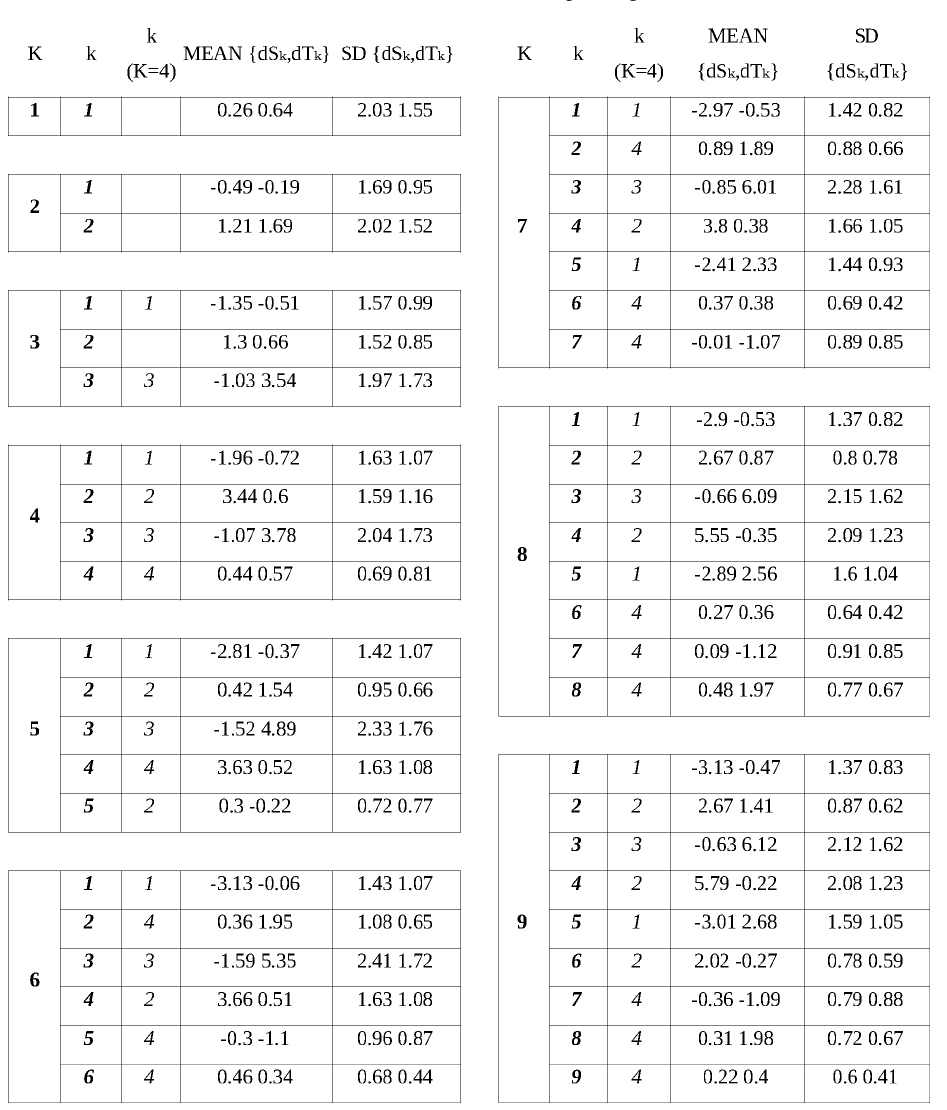
Table 1. The coordinates of the centroids and the standard deviations of salinity and temperature errors within the clusters for a different set of predefined number of clusters, K = 1–9. The numbers in column k correspond to the index of the clusters in Fig. 3 for corresponding set of K clusters. The numbers in column k(K = 4 ) refer to the indices of the corresponding clusters of the case K =